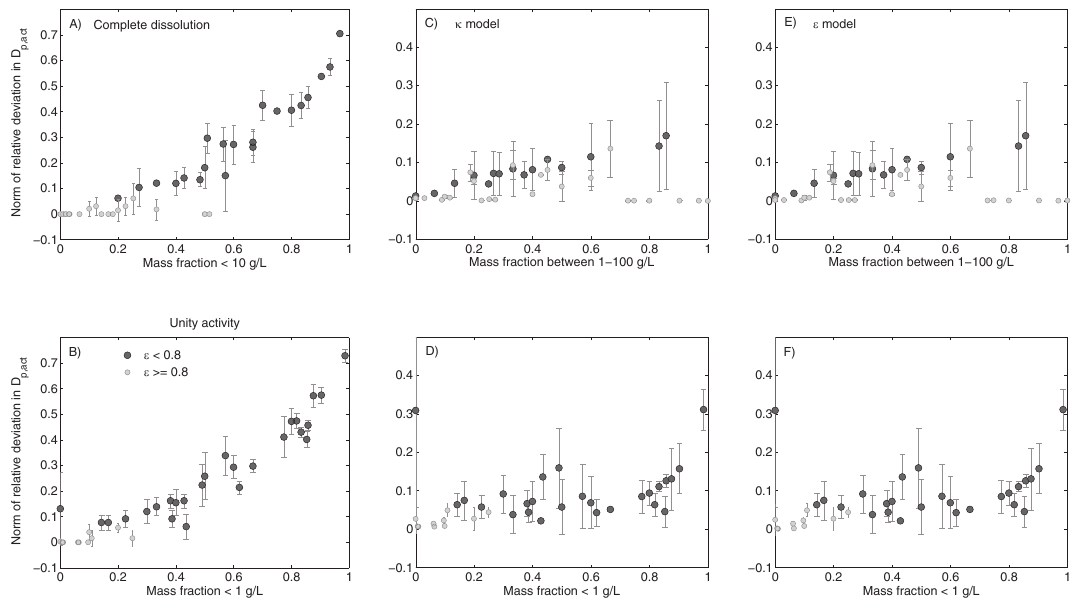
Figure 12. The solubility distribution properties best explaining the performance of the three simplified solubility models, illustrated with the norm of the relative deviation of D p , act as compared with the full model predictions for s = 1, 0.6, 0.3 and 0.1%. The performance of the complete dissolution assumption as a function of the mass fraction with solubilities below the median c t for (a) the ideal organic mixture (median c t = 10gL − 1 ) and (b) the unity organic activity (median c t = 1gL − 1 ) assumptions. The performance of the κ model as a function of the mass fraction with solubilities (c) between 1 and 100gL − 1 for the ideal organic mixture assumption; and (d) below 1gL − 1 for the unity organic activity assumption. The performance of the ε model as a function of the mass fraction with solubilities (e) between 1 and 100gL − 1 for the ideal organic mixture assumption; and (f) below 1gL − 1 for the unity organic activity assumption. The points close to complete dissolution ( ε ≥ 0.8) are shown with lighter grey than the rest of the points. The error bars represent the variability with supersaturation and particle size.